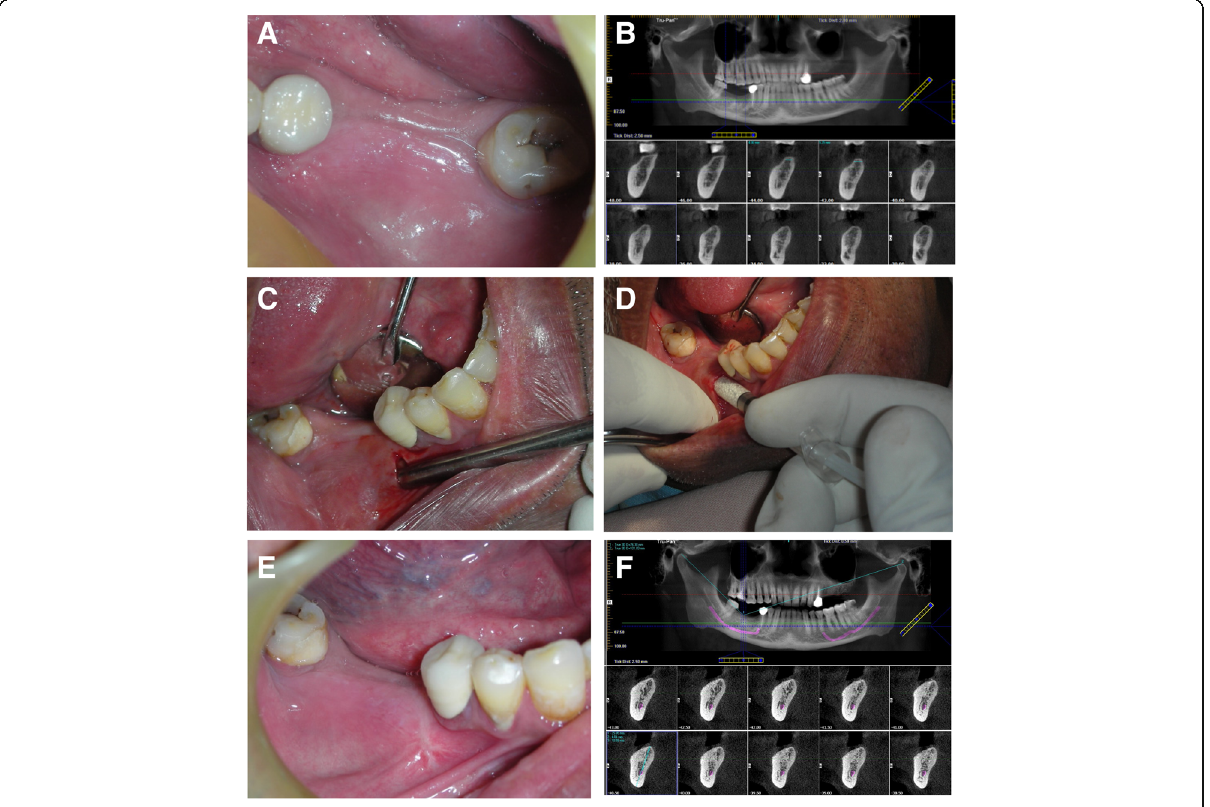
Fig. 1 a Clinical situation with missing mandibular molars. b Preoperative CBCT showing deficient alveolar ridge width. c 5-mm vertical incision made for tunnel preparation and periosteal dissection for the tunnel. d Easy-graft CRYSTAL being injected into the prepared tunnel. e Postoperative healing. Notice the minimal area of scarring at the vertical incision site. f Postoperative CBCT showing increased ridge width and graft